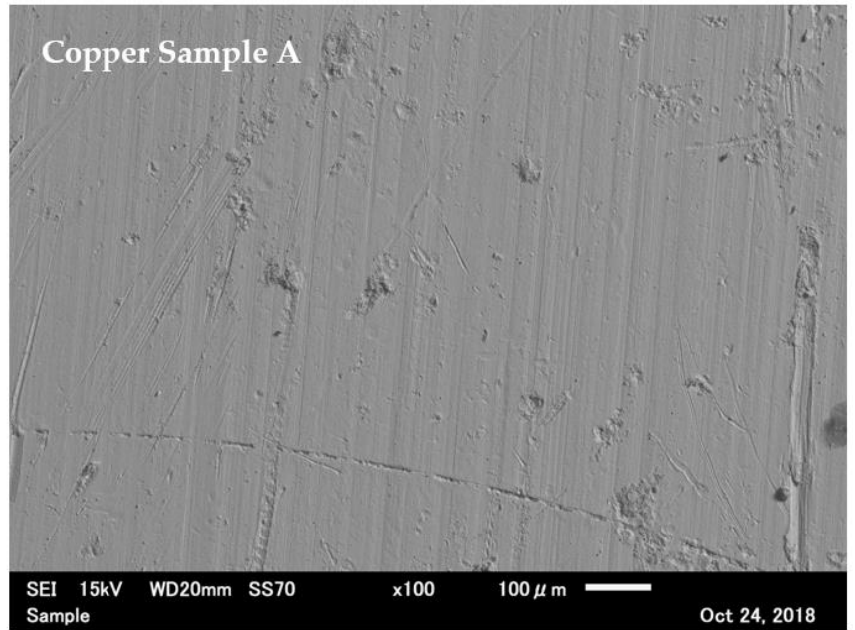
Figure 11. A new copper contact surface before it was subjected to an electrical arc, viewed under an electron microscope at 100 × magnification.